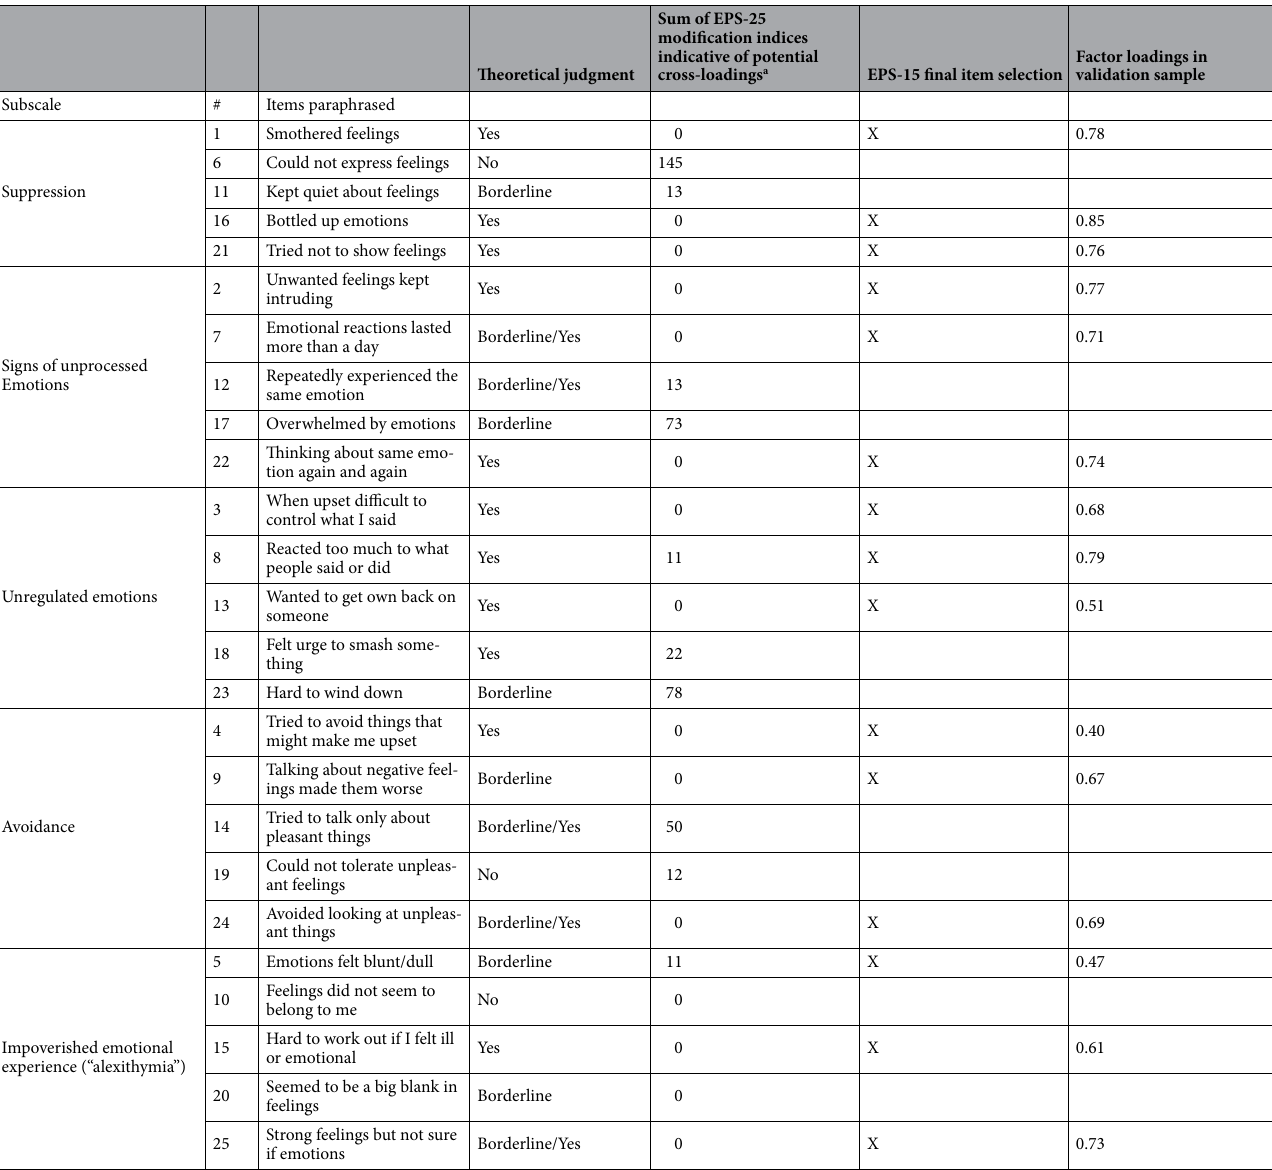
Table 3. Comparison between blinded theoretical judgment (by DM and RJ), initial empirical suggestion of problematic items, and the final EPS-15. EPS-15 Emotional processing Scale. Yes: endorsed as an item typical what the subscale is supposed to measure. No: not endorsed. Borderline: neither typical nor atypical. a This is the sum of all modification indices pertaining to item-factor cross-loadings for each item, as based on the top 30 modification indices for the a priori 5-factor solution for the EPS-25 when fitted on the training data. Note that while there is considerable overlap between blinded theoretical judgments, these modification indices, and the final EPS-15, the reduction of the number of items from 25 to 15 was an iterative process where modification indices were examined for several intermediate scale forms, which for example is why we ultimately decided to include item 5 over items 10 and 20 in the